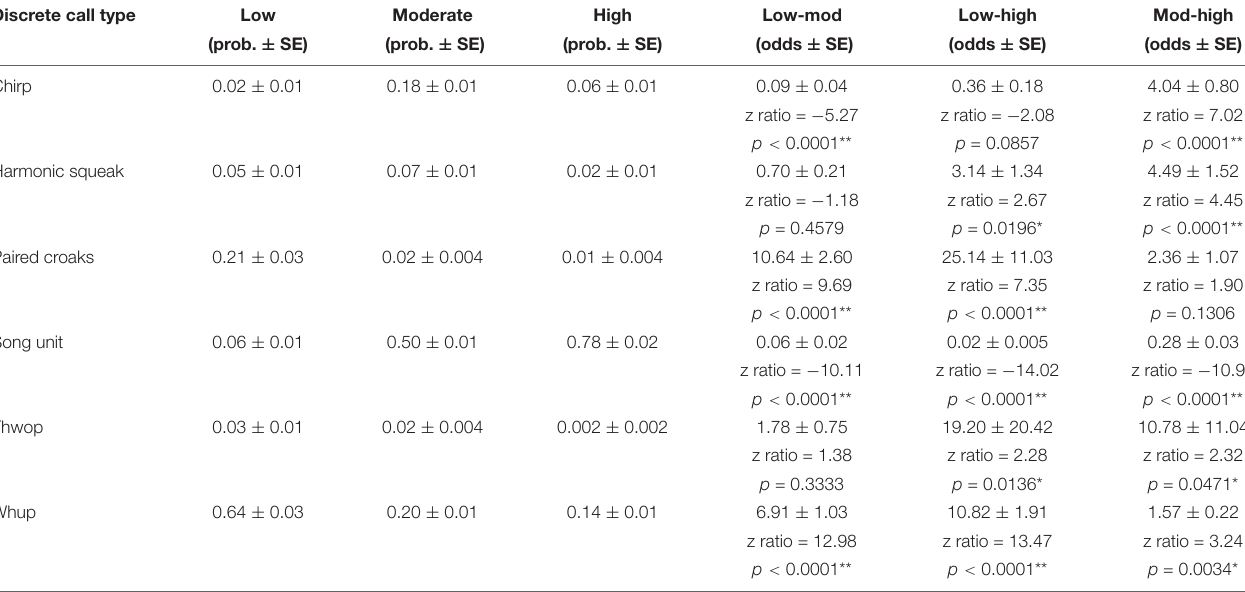
TABLE 4 | Results of the generalized linear models, with the model calculated probability of each call type in each intensity level in the first three columns and the odds ratios in the last three columns. Discrete call type